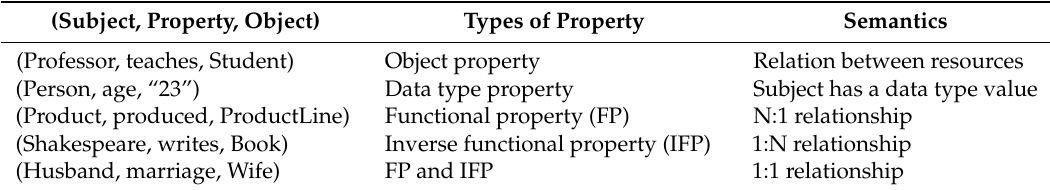
Table A2. Examples of semantic triple data using the OWL notation.